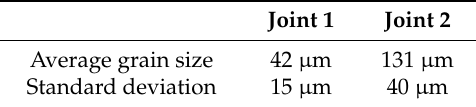
Table 2. The average grain size of the NS Mo alloy laser welding.